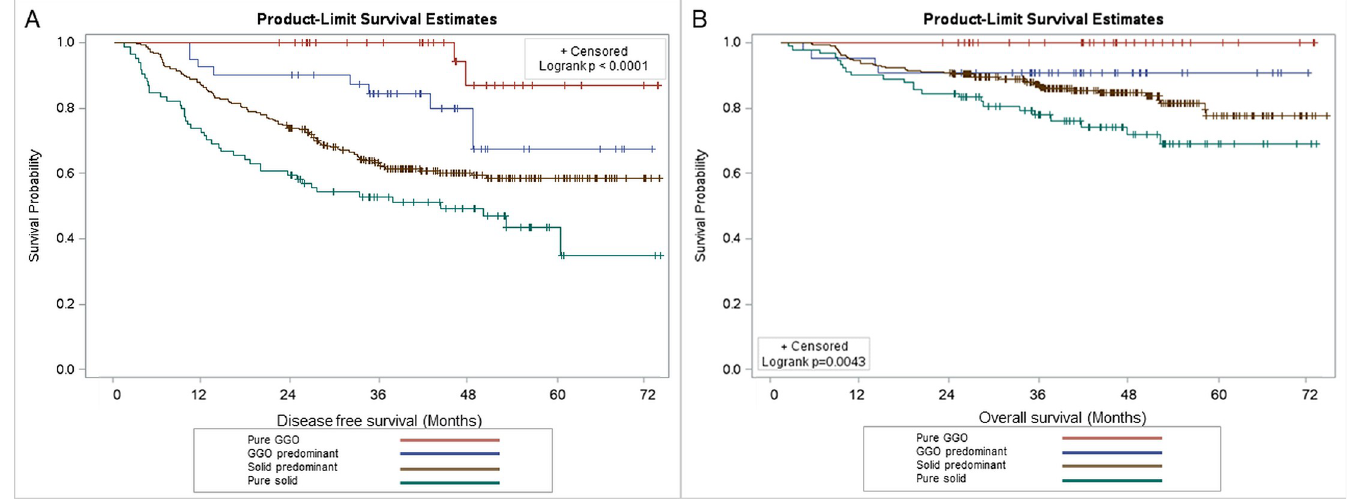
Fig 4. Disease free and overall survival for non small cell lung cancer patients for different C/T ratios. A. Disease free survival for non small cell lung cancer patients with different C/T ratio (p < 0.0001) B. Overall survival for non small cell lung cancer patients with different C/T ratio (p = 0.0043).